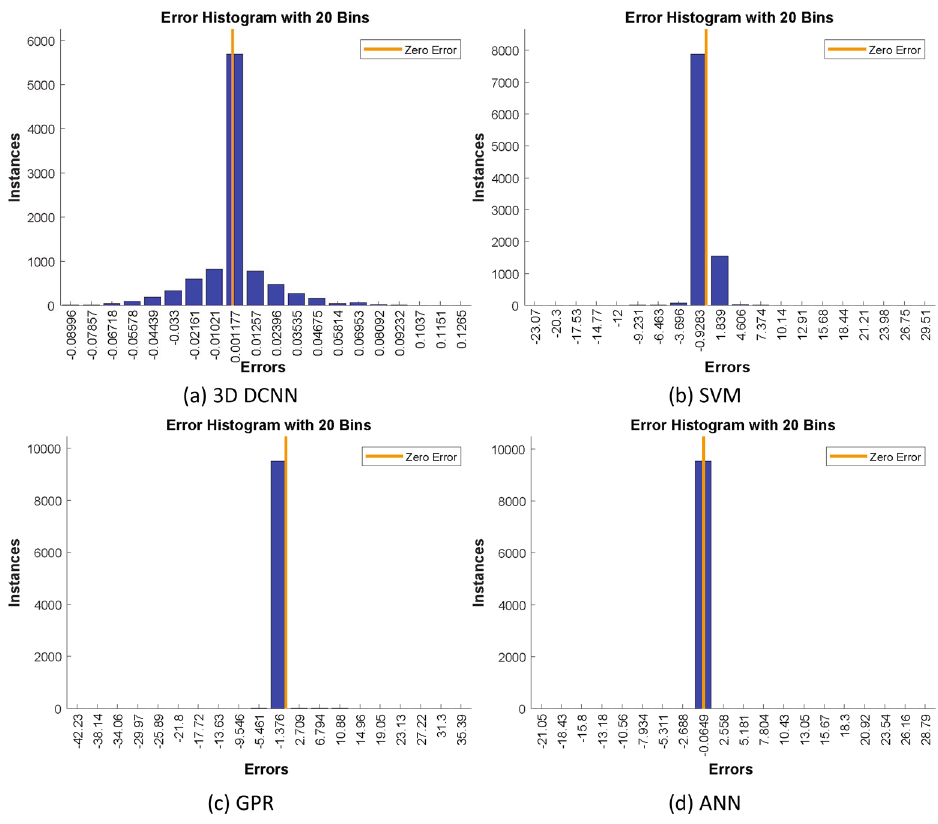
Figure 8. Histograms of errors for different regression